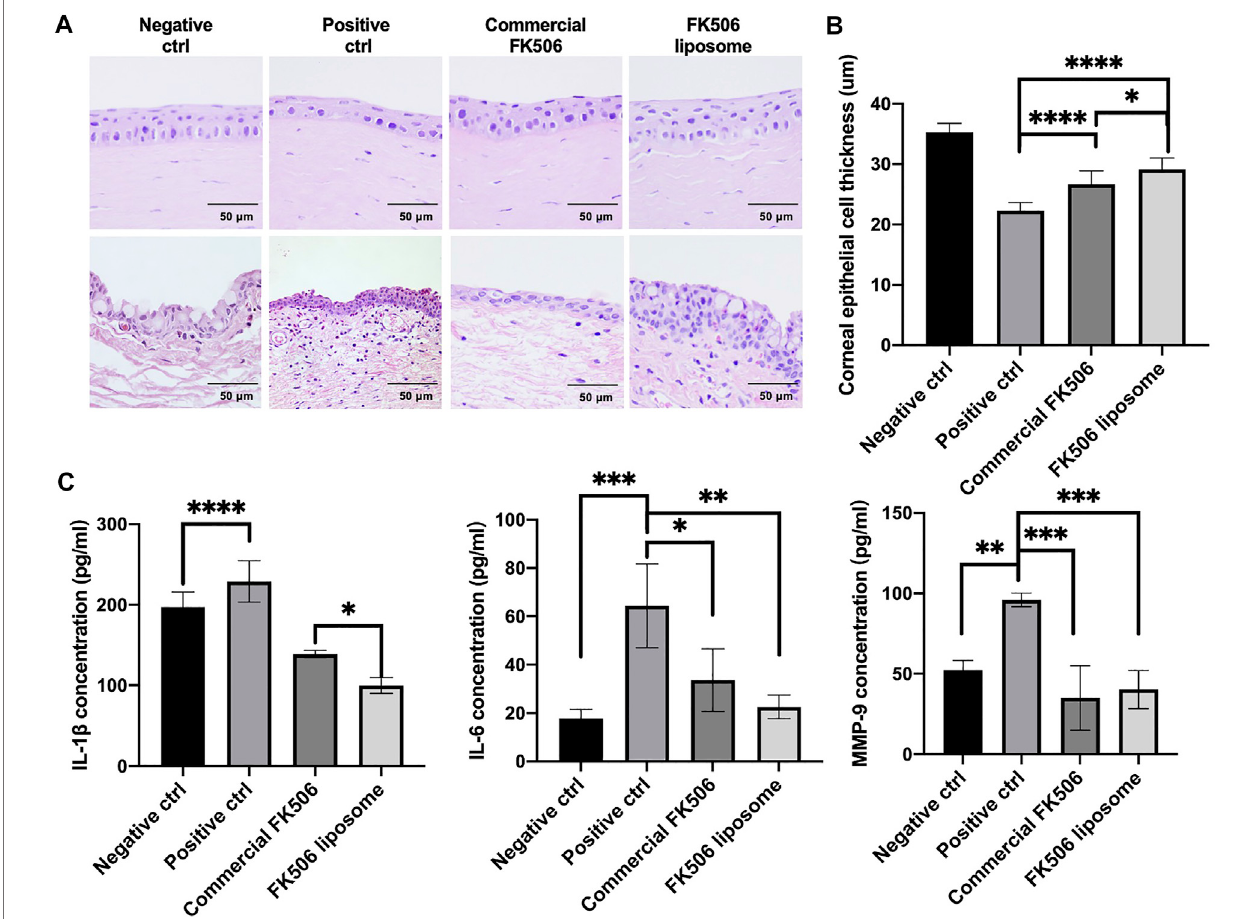
FIGURE 6 | In vivo therapeutic effect evaluations on New Zealand rabbits with dry eye. (A) Representative H and E images of the cornea (upper) and conjunctiva (below) at day 9. (B) Quantitative analysis of corneal thickness at day 9. (C) Concentrations of in fl ammatory factors, including IL-1 β , IL-6, and MMP-9, in the cornea and conjunctiva tissue. * p < .05, ** p < .01, and *** p < .001.